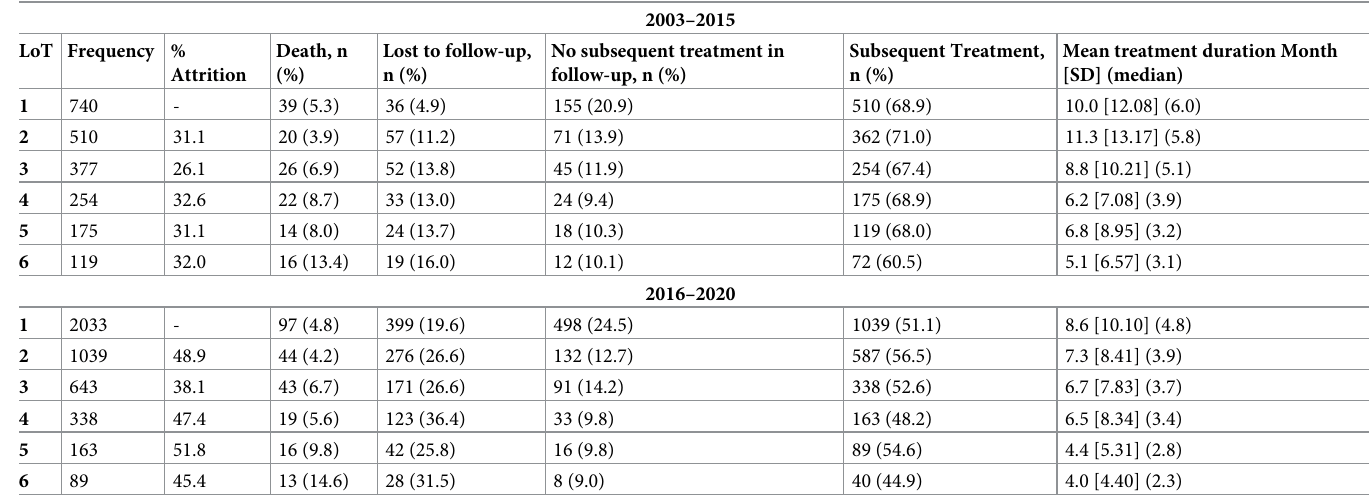
Table 2. Attrition rates by the line of therapy (2003–2015, and